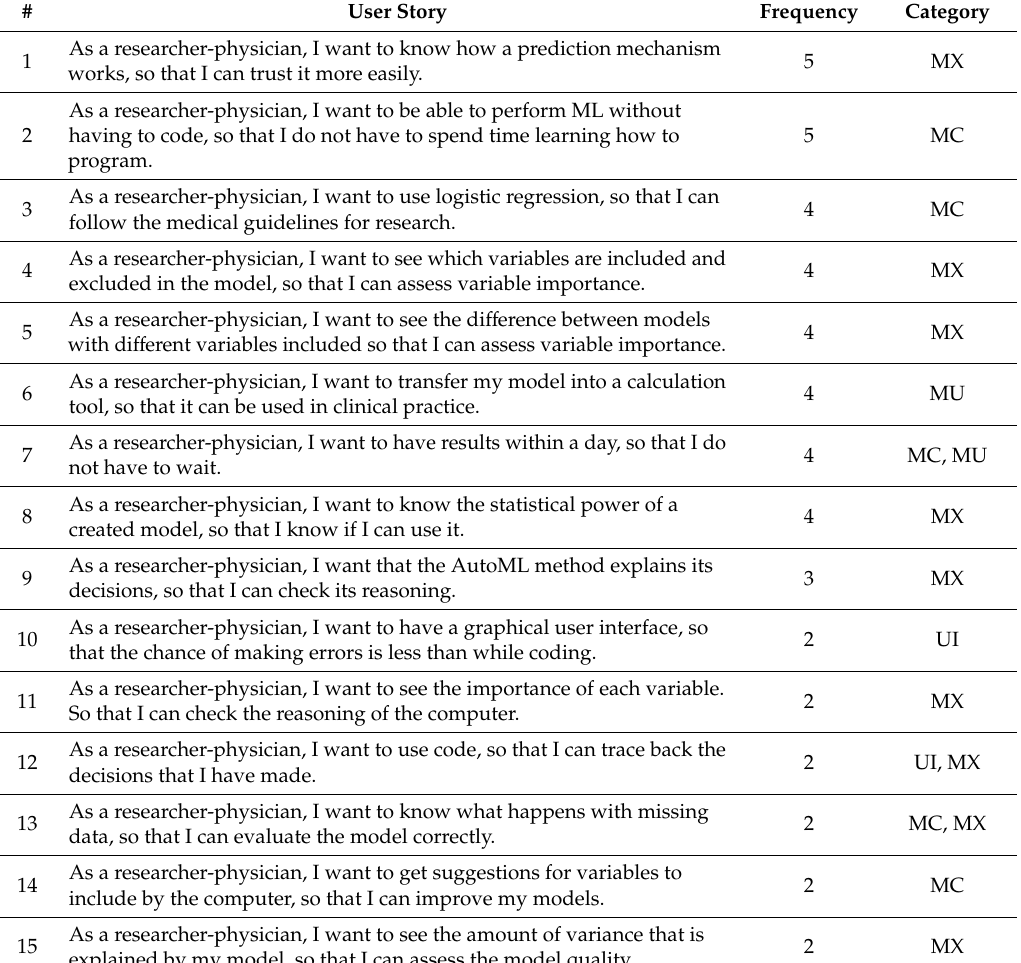
Table A2. Collection of the Top-15 elicited user stories, sorted on descending